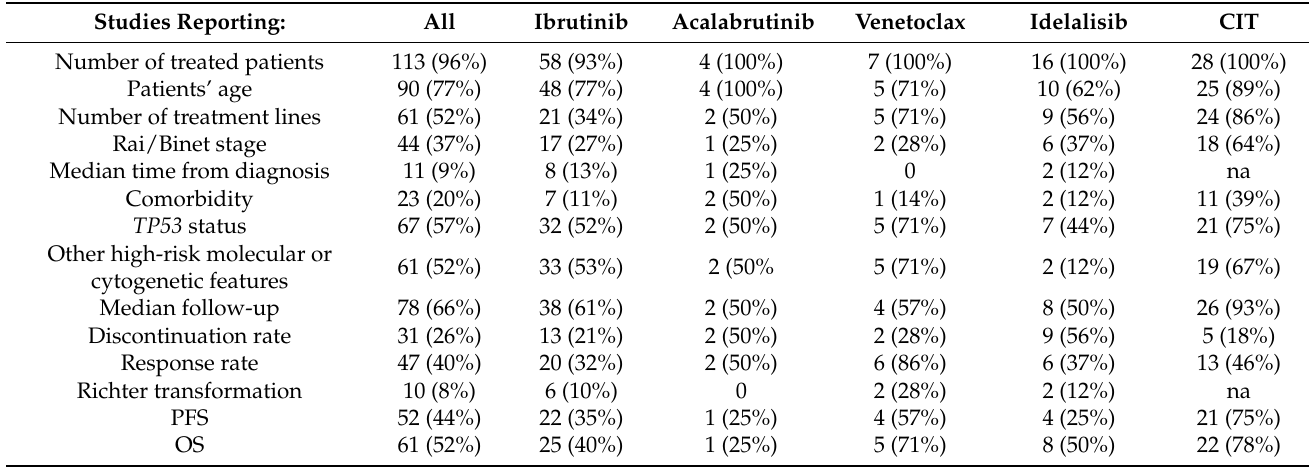
Table 3. Information reported by real-world